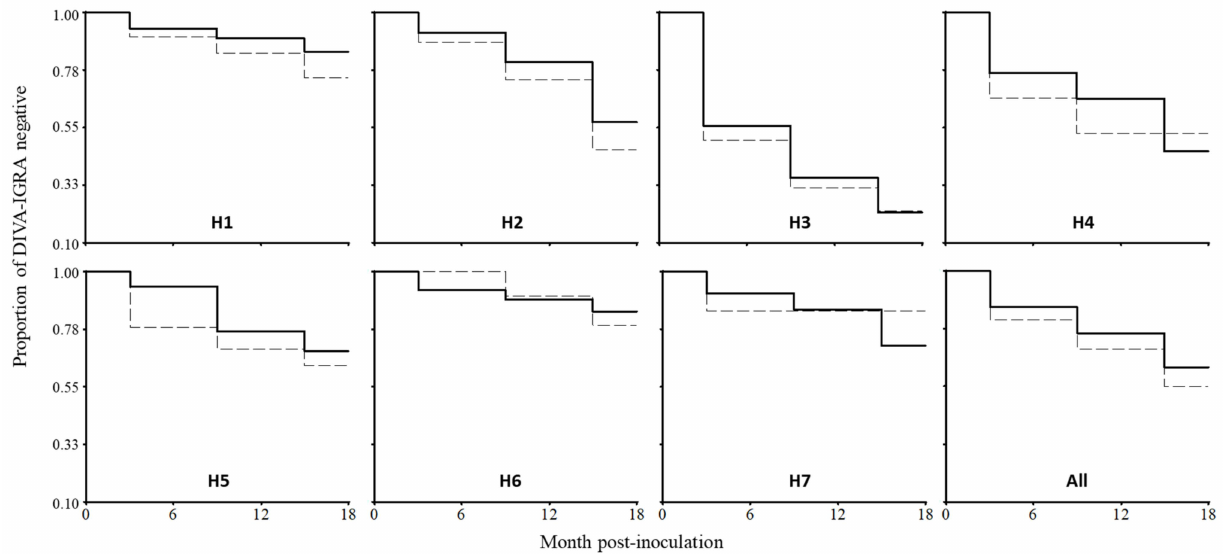
Figure 1. Kaplan–Meier analysis on the comparison of IFN- γ release assay (IGRA) results using DIVA (CFP-10/ESAT-6 and Rv3615c) antigens between BCG-vaccinated (solid lines) and control groups (segmented lines). Tags indicate the herd ID (H1 to H7), and the last graph shows the results obtained with all the animals in the study